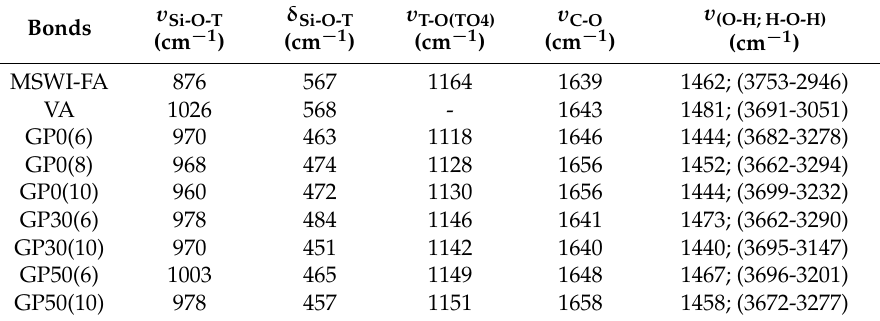
Table 3. IR Characteristic bands of Geopolymer MSWI-FA and